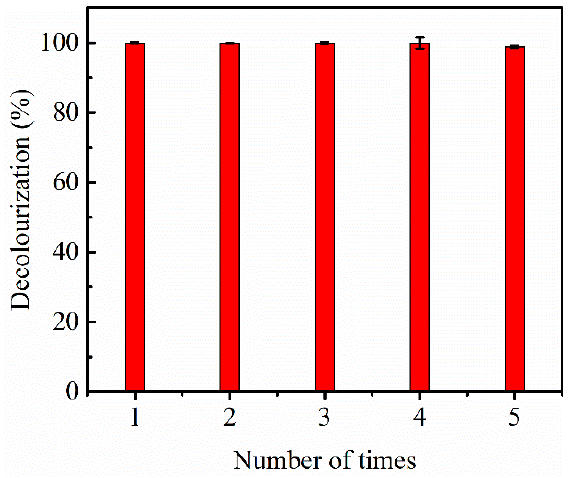
Figure 10. The decolorization efficiency of the Fe 3 O 4 @C nanoparticles. (Conditions: 100 mM MB, 30 mM H 2 O 2 , 2 g/L Fe 3 O 4 @C nanoparticles, the temperature of 40 °C, and initial pH value of 3.0).